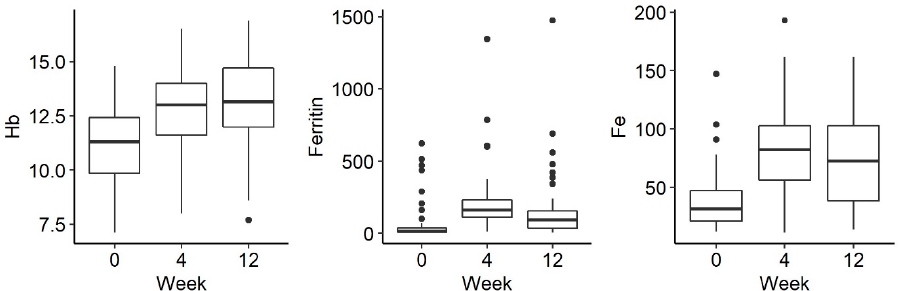
Figure 1. Changes in Hg (hemoglobin), ferritin and Fe (iron) levels over time: before iron administration and 4 and 12 weeks after administration.